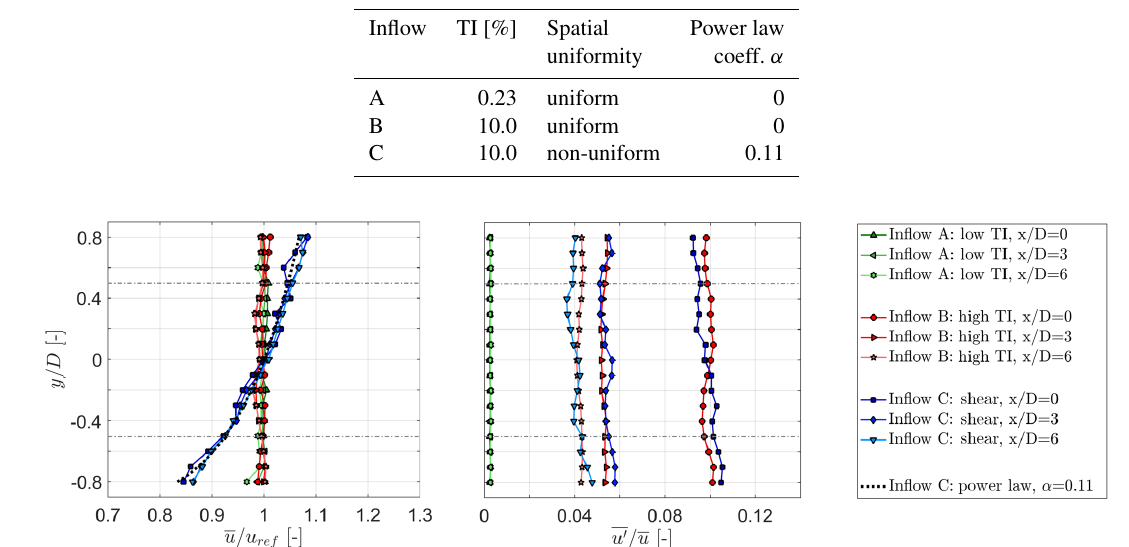
Table 1. Characteristics of the three different investigated inflow conditions.